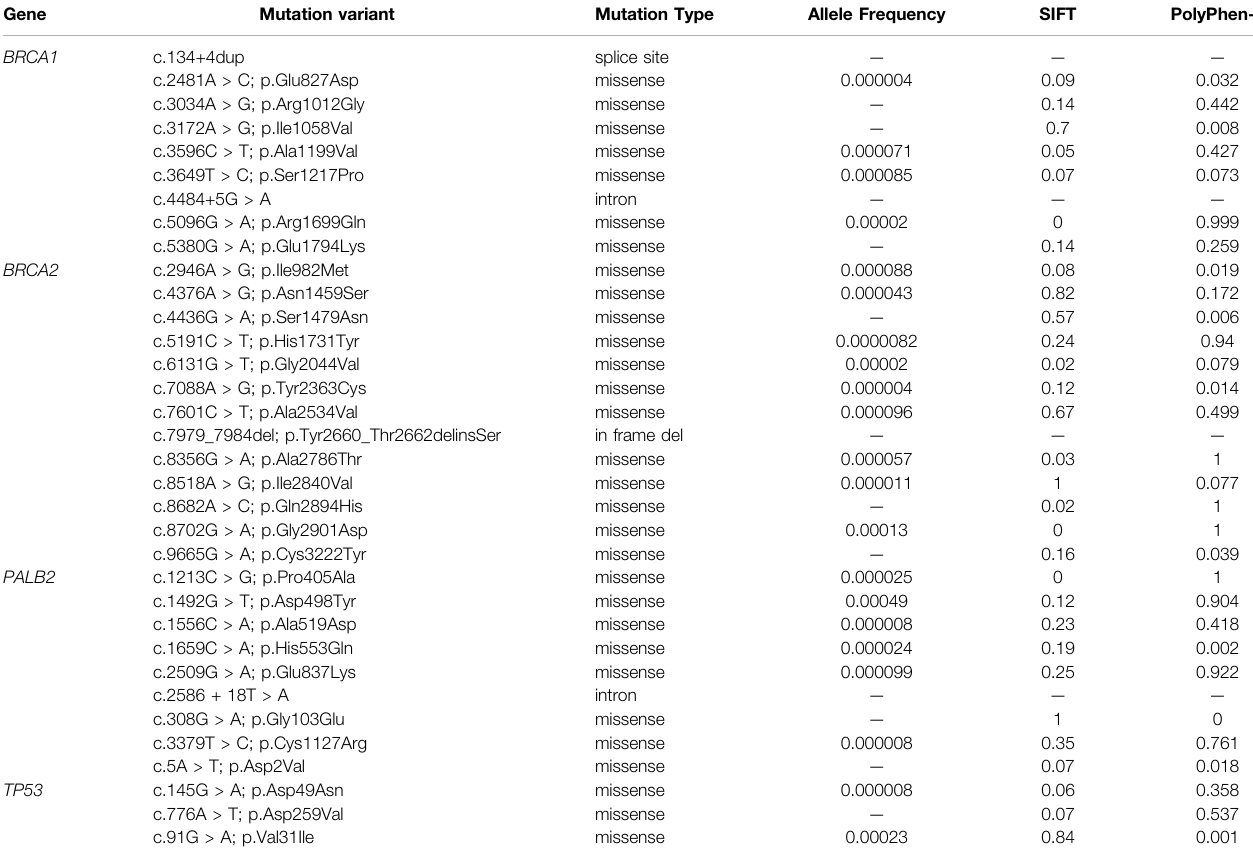
TABLE 6 | List of VUSs in high penetrance breast cancer predisposition